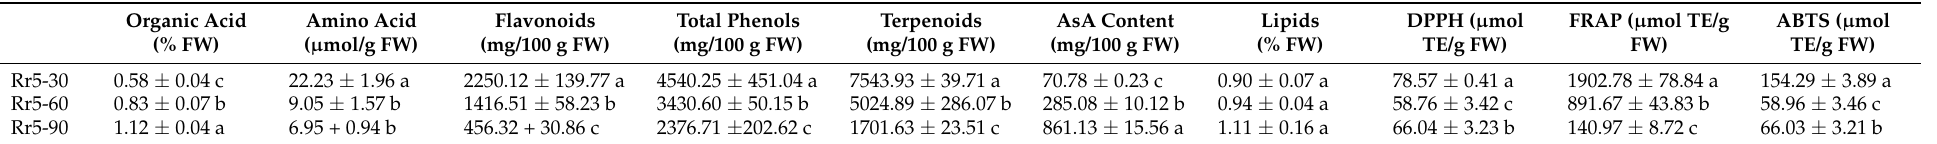
Table 1. Bioactive substance content and in vitro antioxidant capacities during R. roxburghii fruit development. (Lowercase letters in the table indicate significance, and different letters indicate significant differences among the